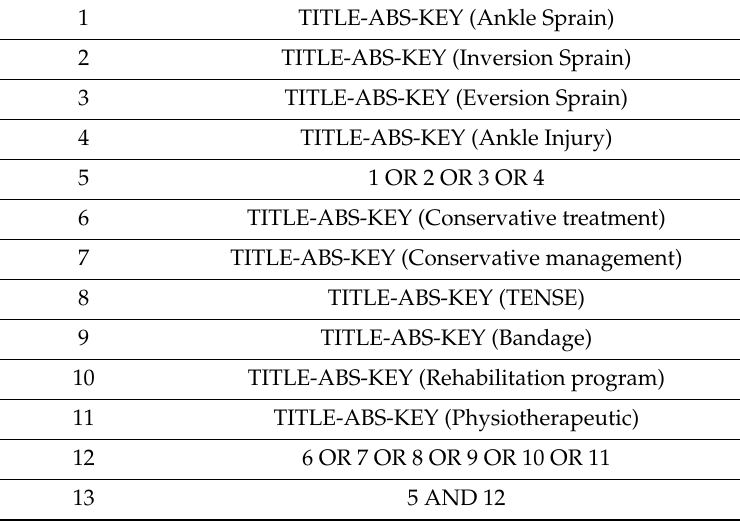
Table A3. SCOPUS. Total articles: 597.